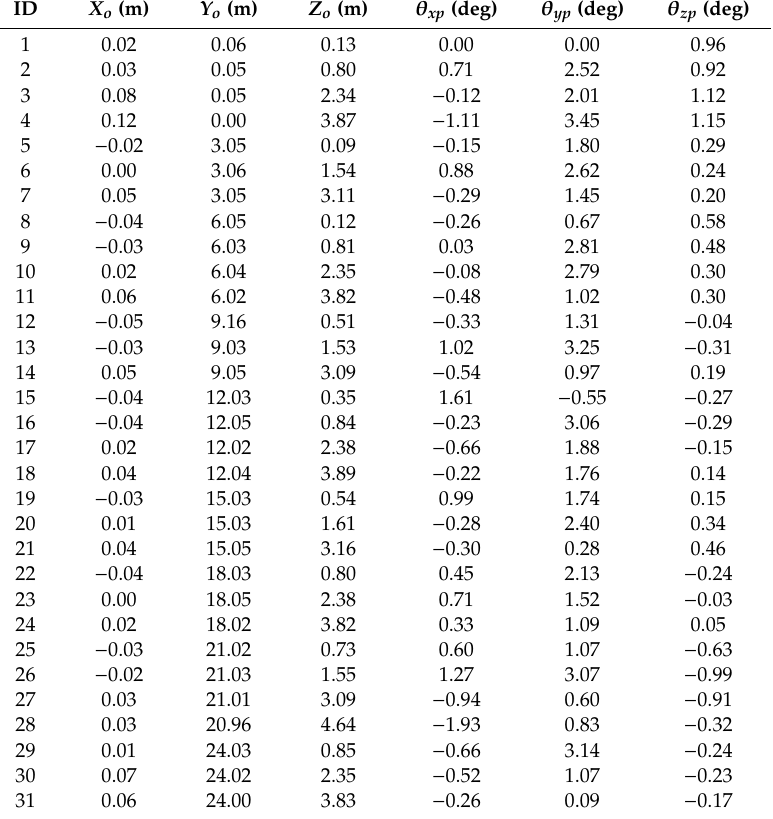
Table 11. MLS-based panel parametrization for one of the MSE wall faces at Site-2.